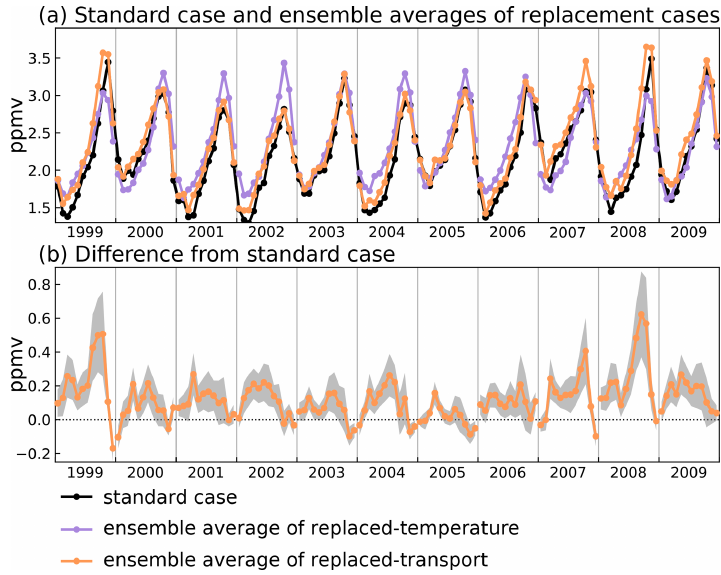
Figure 3. (a) Time series of SMR LDP for the standard case (black) and the average across replacement calculations with replaced temperature (purple) and replaced transport (orange). Further described in Sect. 3.1. (b) Difference between replaced-transport ensemble average and the standard